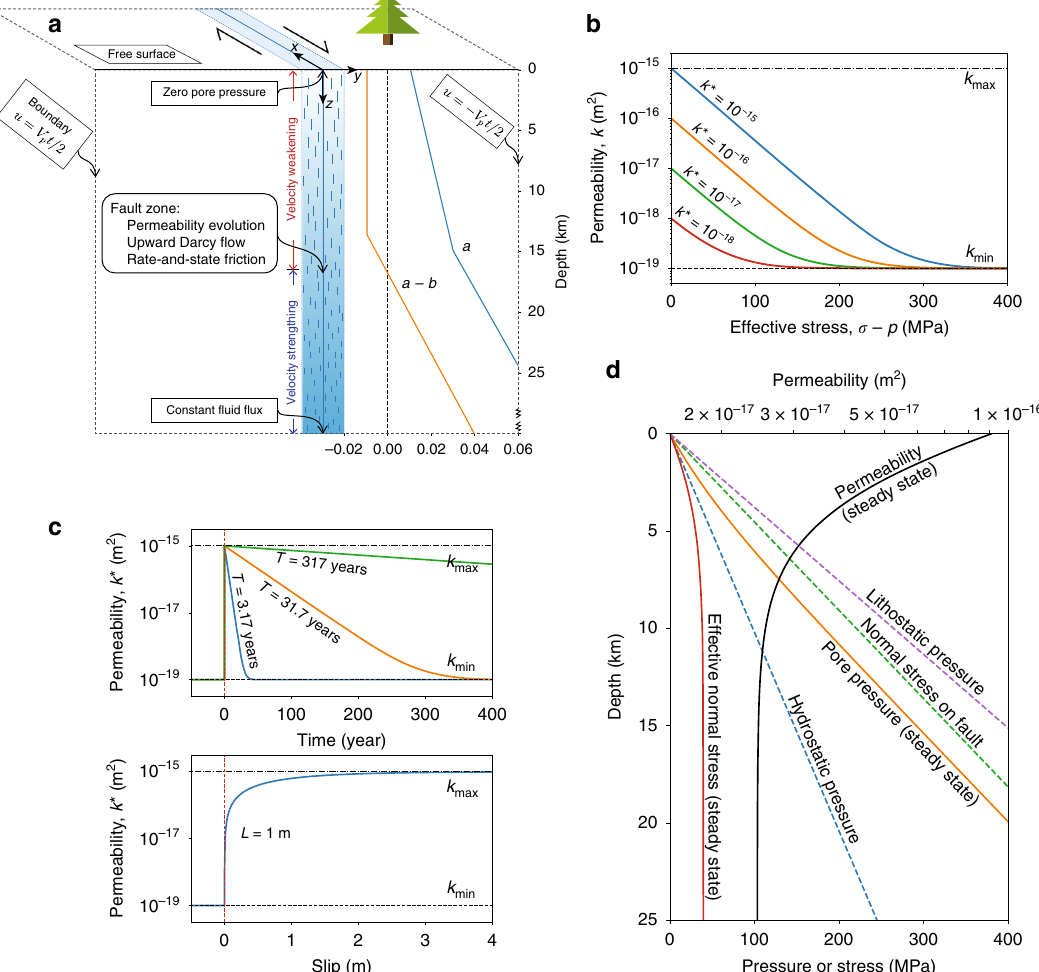
Fig. 1 Model setting. a Strike-slip earthquake sequence simulations in a linear elastic solid with rate-and-state friction, fault zone fl uid transport, and pore pressure evolution model; distributions of rate-and-state a and a − b shown on right. b Permeability decreases with increasing effective normal stress, shown for different k *, a reference permeability that c decreases over healing time scale T and increases during coseismic slip over slip distance L . d Distribution of permeability, pore pressure, and effective normal stress for steady upward fl uid fl ux using the permeability model in b , c . Note how effective stress becomes independent of depth. Shown for steady fl ux q 0 = 3 × 10 − 9 m/s, σ * = 30MPa, k min ¼ 10 (cid:2) 19 m 2 , k max ¼ 10 (cid:2) 15 m 2 , L = 1 m, T = 3.17